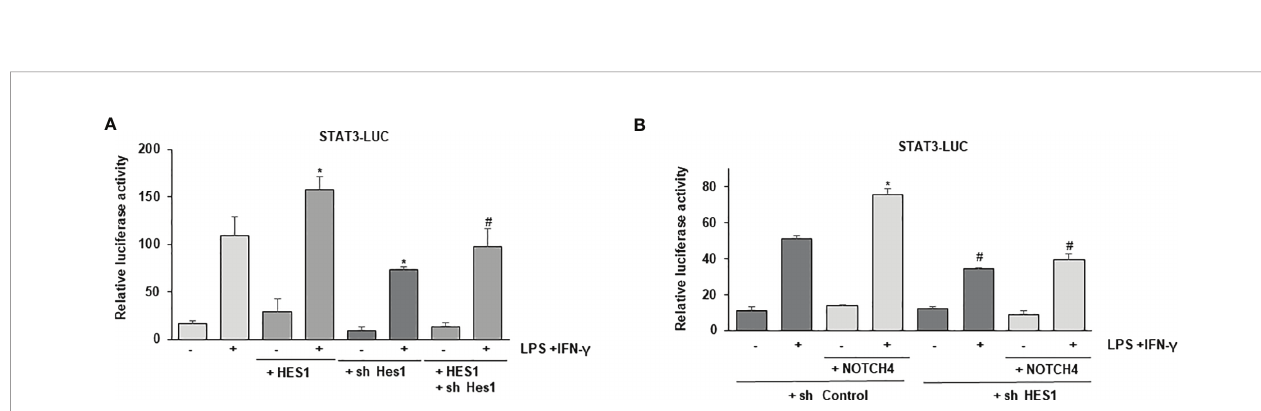
FIGURE 7 | Effect of HES1 expression on the activation of STAT3 induced by NOTCH4 in macrophages treated with LPS and IFN- g . (A) Analysis of luciferase activity in Raw 264.7 cells transiently transfected with a STAT-luciferase reporter in the presence of STAT3 (STAT3-LUC) and a Hes1 expression vector or the corresponding empty vector, or with speci fi c shRNA for Hes1 or its control. One day after transfection, cells were stimulated with LPS (100 ng/ml) and IFN- g (10 U/ ml) for 24 h before analysis. The mean ± SD of three independent experiments is shown. One-way ANOVA/Bonferroni ’ s post-tests were performed. *p<0.05 compared to the control transfected cells activated with LPS and IFN- g . # p<0.05 compared to the cells transfected with Hes1 and activated. (B) Analysis of luciferase activity in Raw 264.7 cells transiently transfected with a STAT-luciferase reporter in the presence of STAT3 (STAT3-LUC) and a Notch4 expression vector or the corresponding control empty vector and with speci fi c shRNA for Hes1 or control shRNA. Cells were activated as previously described. The mean ± SD of three independent experiments is shown. One-way ANOVA/Bonferroni ’ s post-tests were performed. *p<0.05 compared to the control transfected cells activated with LPS and IFN- g . # p<0.05 compared to the activated cells transfected with control